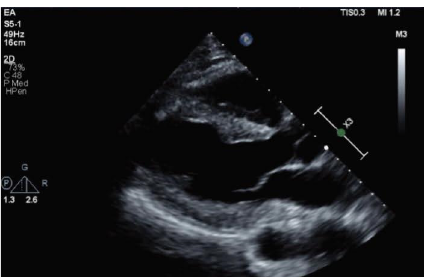
Figure 7: Transthoracic Echocardiogram 4 weeks after initial presentation, showing trace circumferential pericardial efusion. Te maximum diastolic dimension of the pericardial efusion seen is 7 mm posteriorly. Tere are no echocardiographic fndings for cardiac tamponade. TEE at a 2-monthfollow-up showed no sig- nifcant